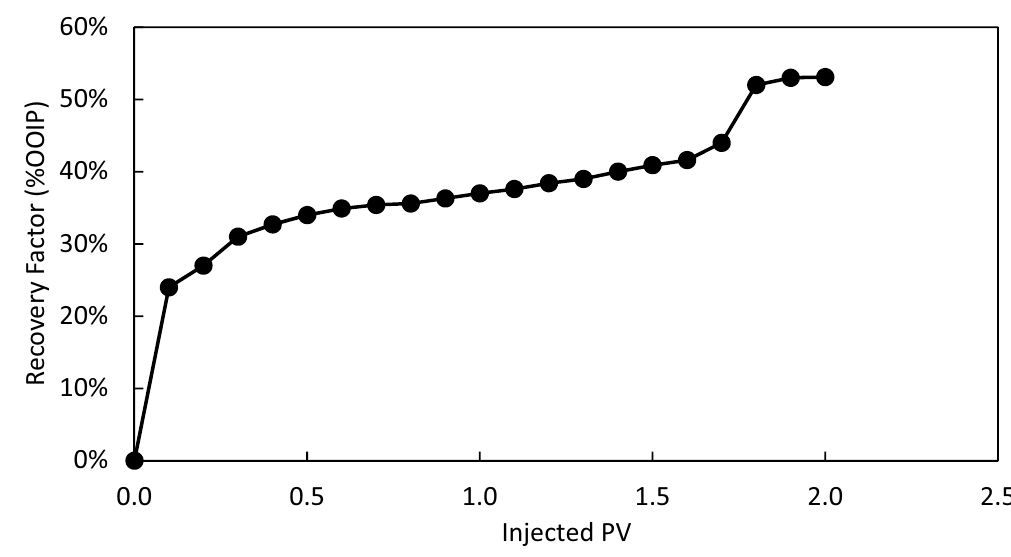
Figure 16. Ultimate oil recovery factor versus injected PV during injection of DIW into the dual patterned glass micromodel initially saturated with crude oil (top porous medium) and a solid gel formed from 3 wt% silica and 3 wt% NaCl in DIW (bottom porous